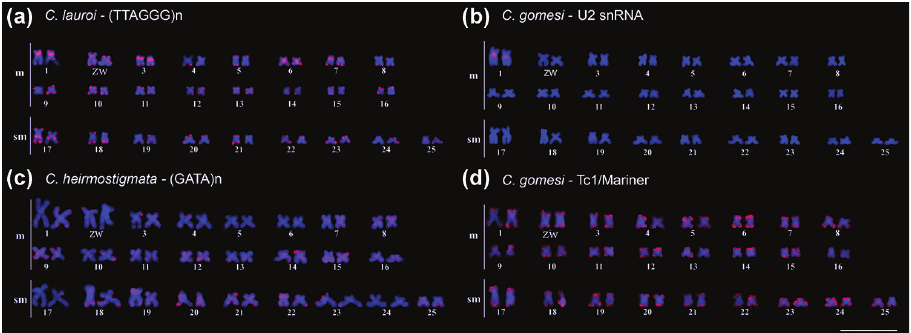
Figure 2. Fluorescence in situ hybridization using distinct classes of repeated DNA sequences as probes: In a karyotype of C. lauroi submitted to (TTAGGG) U2 snRNA sites (red) c Karytype of C. heirmostigmata submitted to (GATA) type of C. gomesi evidencing Tc1/Mariner mapping (red). Scale bar: 10